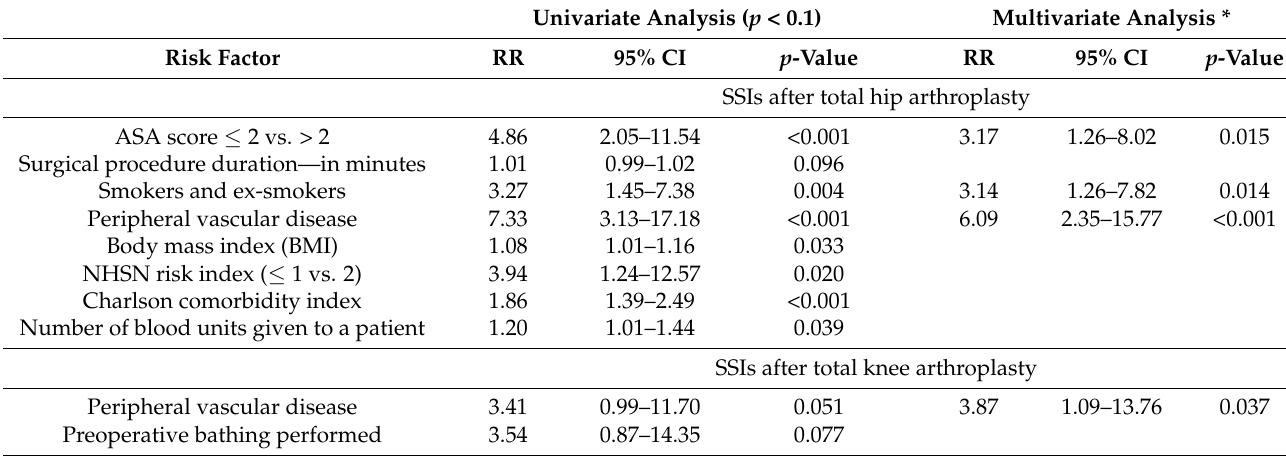
Table 2. Risk factors of surgical site infections (SSIs) after total hip arthroplasty and total knee arthroplasty according to the univariate and multivariate regression analysis.